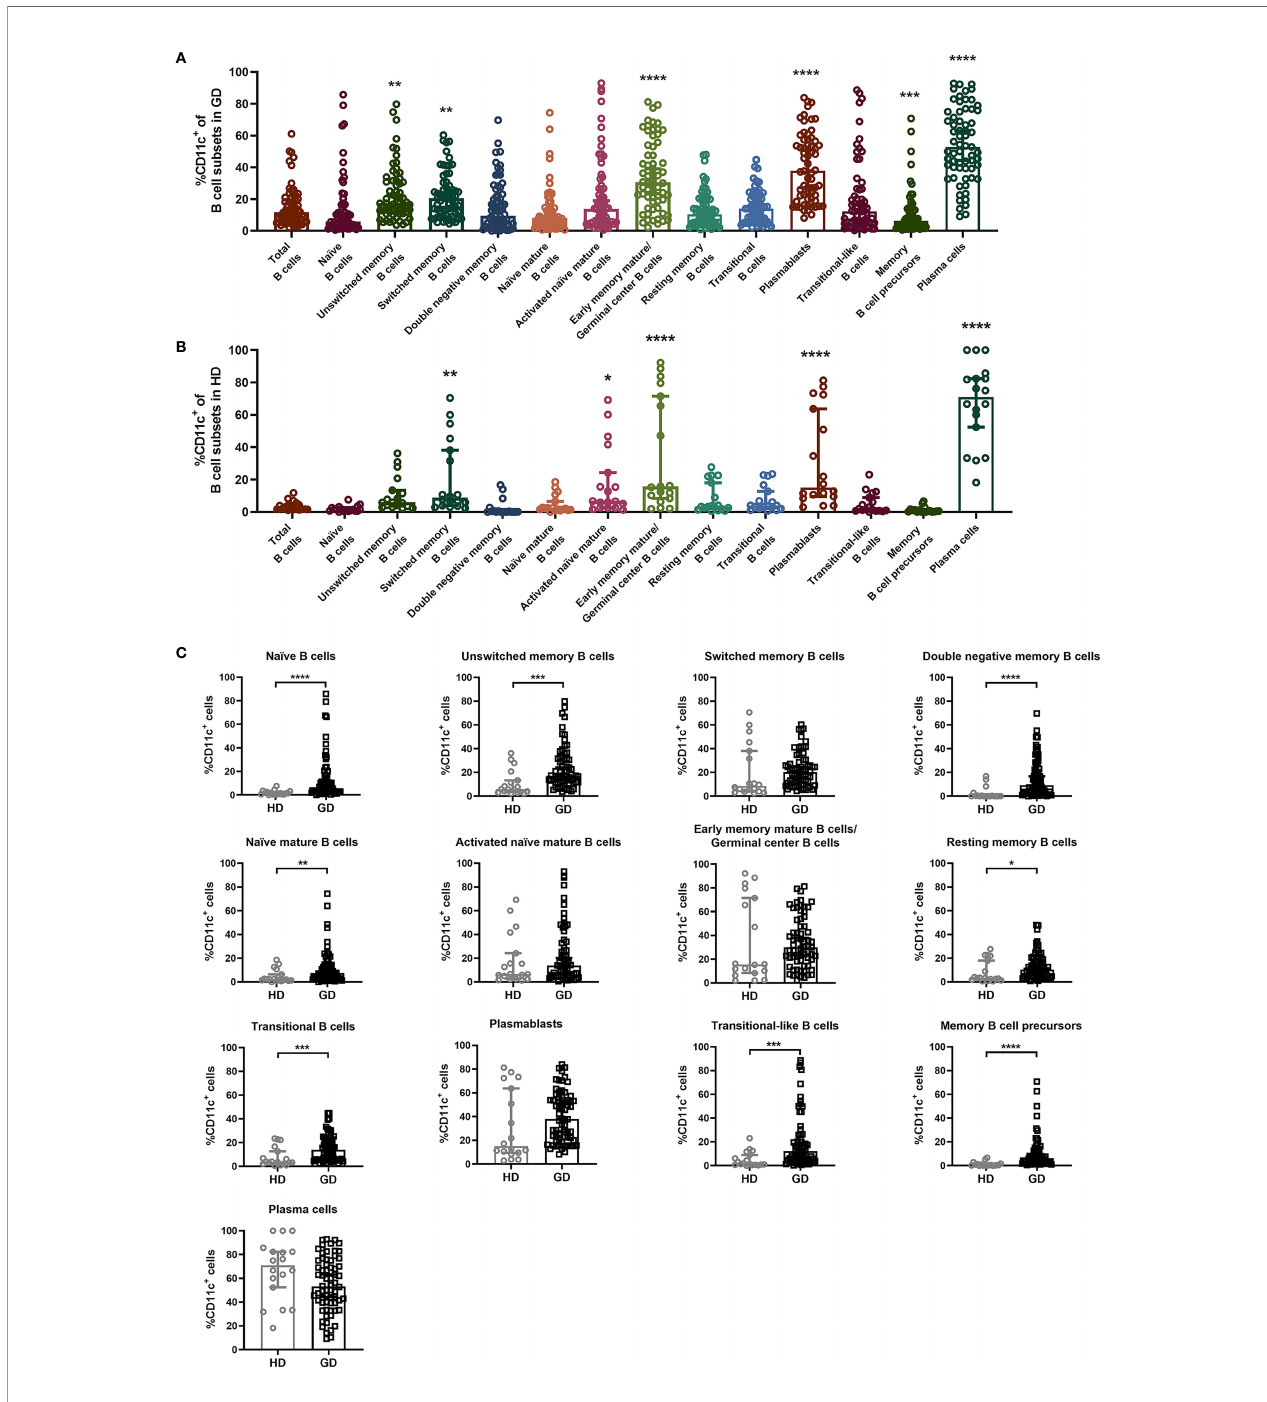
FIGURE 3 | Expression distribution ofCD11c in a variety of B-cellsubsets. (A,B) TotalCD19 + B cells were divided into 13 B-cell subsets according to the expression of IgD,CD27, CD38, and CD138: naïveB cells (CD27 - IgD + ),unswitched memory B cells (CD27 + IgD + ),switched memory B cells (CD27 + IgD - ), doublenegative memoryB cells (CD27 - IgD - ),naïve mature B cells(CD38 - IgD + ),activated naïve mature B cells (CD38 + IgD + ),early memory mature B cells/germinal center B cells (CD38 + IgD - /CD38 high IgD - ), resting memoryB cells (CD38 - IgD - ), transitional B cells (CD38 - CD27 + ), plasmablasts (CD38 + CD27 + ), transitional-like B cells (CD38 + CD27 - ), memory B-cell precursors (CD38 - CD27 - ), and plasma cells (CD138 + ). Comparisonofthe frequency of CD11c + B cells inthe above 13 B-cell subsets in 68 GD patients and 18 HD patients. Nonnormally distributeddata are expressed as the median and IQR, assessed bythe Kruskal – Wallis multiple comparisontest. P < 0.05 was consideredstatistically signi fi cant. *comparedto total B cells, P < 0.05; ** comparedto total B cells, P < 0.01; *** comparedto totalB cells, P < 0.001; **** compared to total B cells, P < 0.0001. (C) The comparison ofCD11c + B-cellcell frequency in13 kinds of B-cell subsets between the HD group and GD group. Nonnormallydistributed data are expressed as the median and IQR, assessed